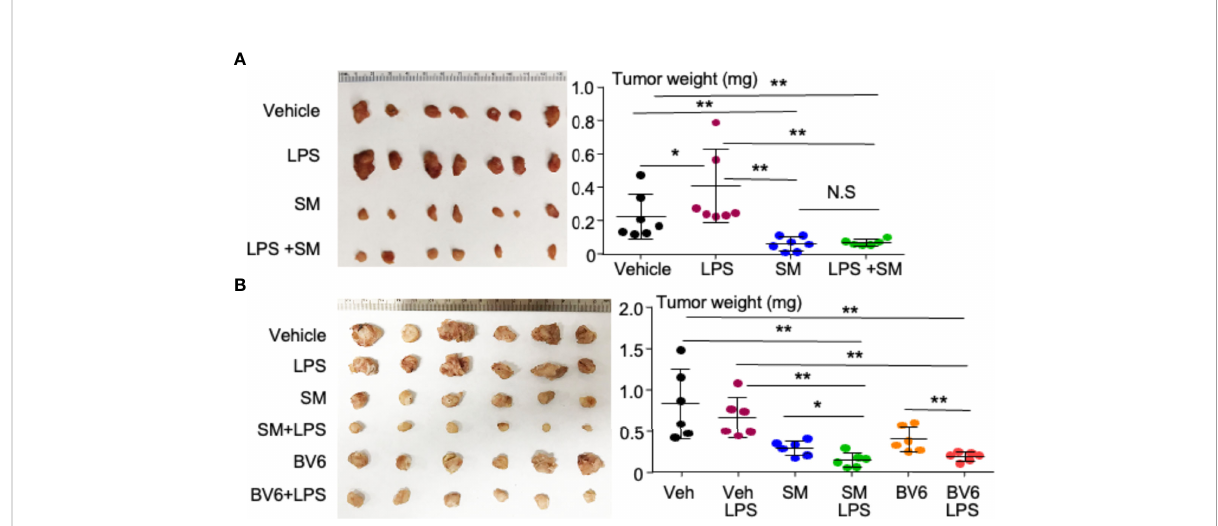
FIGURE 2 LPS, given together with an IAP antagonist, induces the regression of TNBC in mouse model. (A) 2 × 10 4 MDA-MB-231 cells were injected into the second left mammary fat pad of female NSG mice. From the third day, the mice were treated with vehicle, 1 m g of LPS, 3 mg/kg of SM-164 (SM), or their combination for 4 weeks. The mice were euthanized, and the tumors were collected to scale their weight. (B) 2 × 10 5 MDA-MB- 231 cells were injected into female NSG mice as in panel (A) . After 2 weeks, when the tumors were visible, the mice were treated with vehicle, 3 mg/kg of SM, or 10 mg/ml of BV6 alone or in combination with 1 m g of LPS for 3 weeks. The tumor weight was determined as in panel (A) . Six to seven in each group. *p < 0.05, **p < 0.01. NS, Not signi fi cant. LPS, lipopolysaccharide; IAP, inhibitor of apoptosis protein; TNBC, triple- negative breast